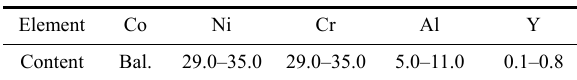
Table 1 Chemical composition of NiCrCoAlY